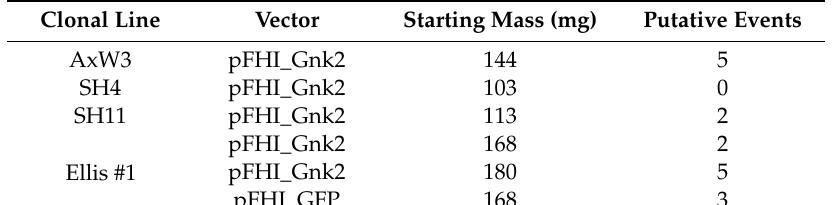
Table 2. Transformation e ffi ciency of American chestnut somatic embryo lines (AxW3-46B (AxW3), Spring Hole-4A (SH4), Spring Hole-11D (SH11), and Ellis #1) with pFHI_Gnk2 vector and positive control (Ellis #1 transformed with pFHI_GFP), after 5 weeks in selection medium.